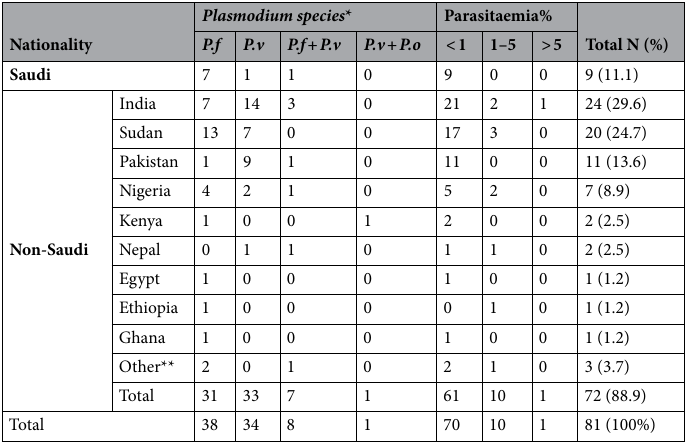
Table 3. Patient nationality distribution according to Plasmodium species and parasitaemia%. (*) P.f ( P. falciparum ), P.v ( P. vivax ), P.o ( P. ovale ). (**) other are non-Saudi and their nationalities were not recorded.